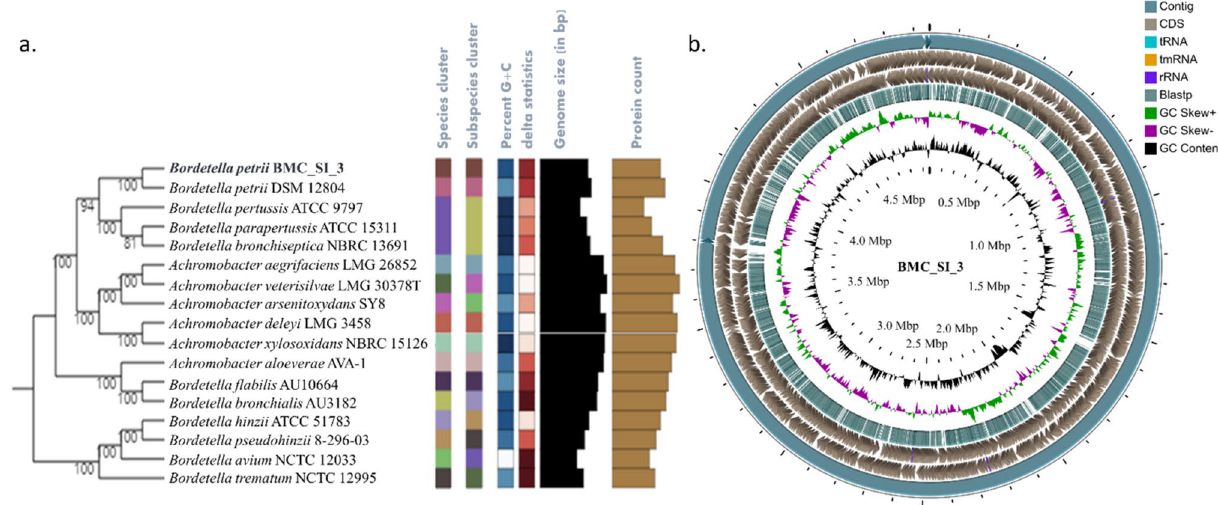
Figure 2. TYGS result for the BMCSI 3 genome ( a ). Circular representation of BMCSI 3 genome features as per the CG viewer server ( b